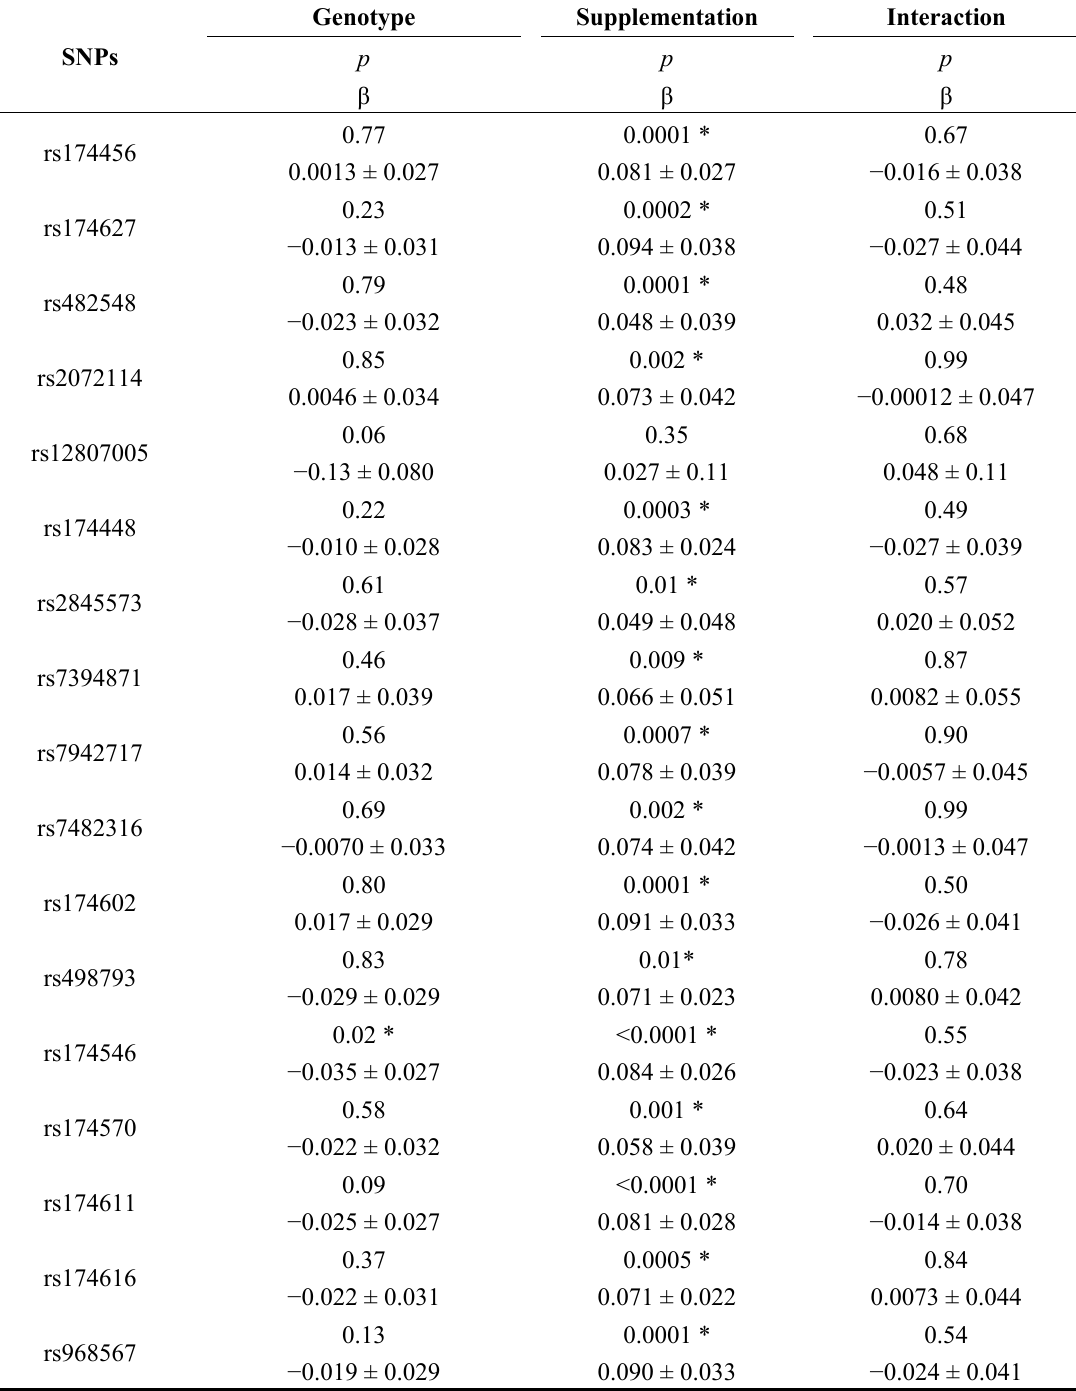
Table 4. Effect of the genotype, the n -3 PUFA supplementation and the interaction (genotype by supplementation) on TG levels ( n =